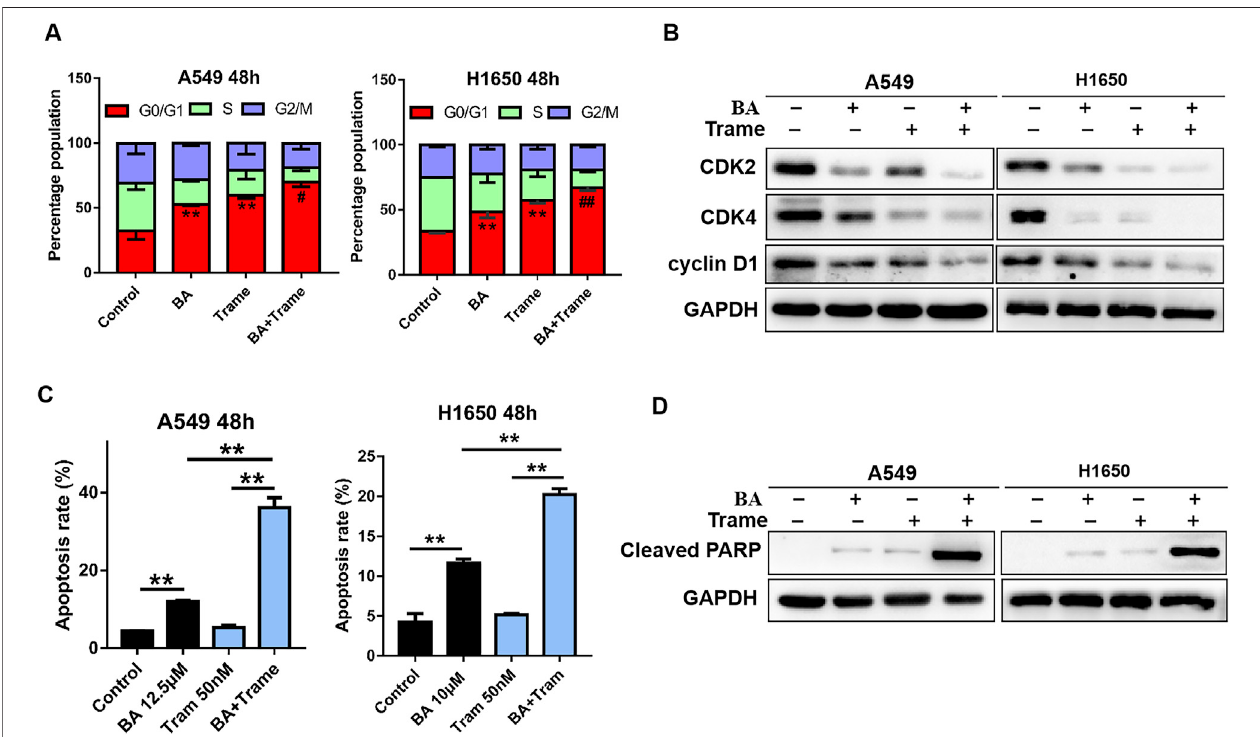
FIGURE6| TrametinibincreasesBA-inducedcyclearrestandapoptosisinA549cells. (A) A549andH1650cellsweretreatedwith12.5 μ MBA,50 nMtrametinib, or in combination for 48 h, and cells were harvested for cell cycle analysis by fl ow cytometry. (B) A549 and H1650 cells were treated with 12.5 μ M BA, or 50nM trametinib,orincombinationfor48 h,andtheexpressionsofcyclinD1,CDK2,andCDK4wereevaluatedbyWesternblots. (C) A549andH1650cellsweretreatedwith 12.5 μ M BA, or 50 nM trametinib, or in combination for 48 h, and apoptosis was detected using fl ow cytometry. (D) A549 and H1650 cells were treated with 12.5 μ M BA, or 50nM trametinib, or in combination for 48 h, and the expression of cleaved PARP was evaluated using Western blots. # p < 0.05, ## p < 0.01 vs BA or trametinib alone, ** p <